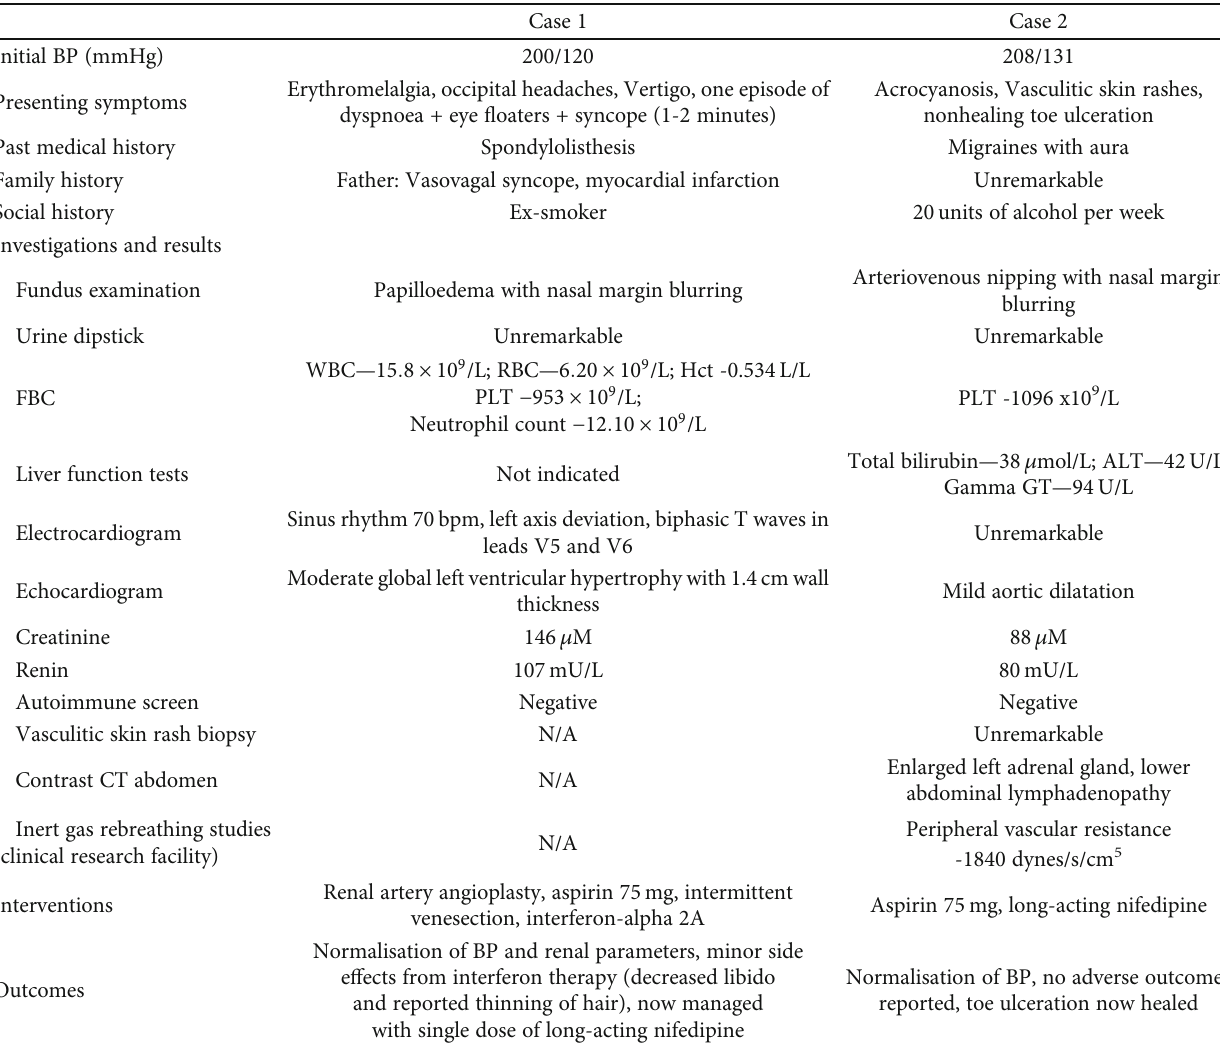
Table 1: Summary of case